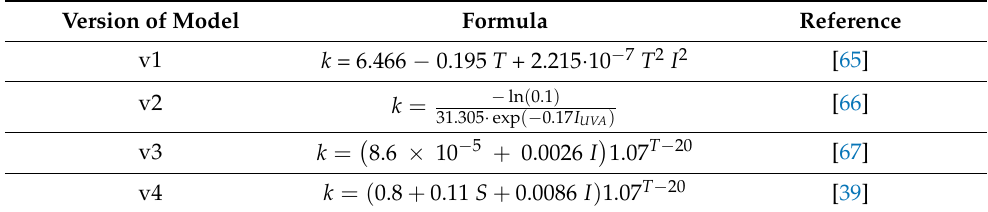
Table 3. Mathematical formulas for the survival rate of E. coli used in different versions of the selected